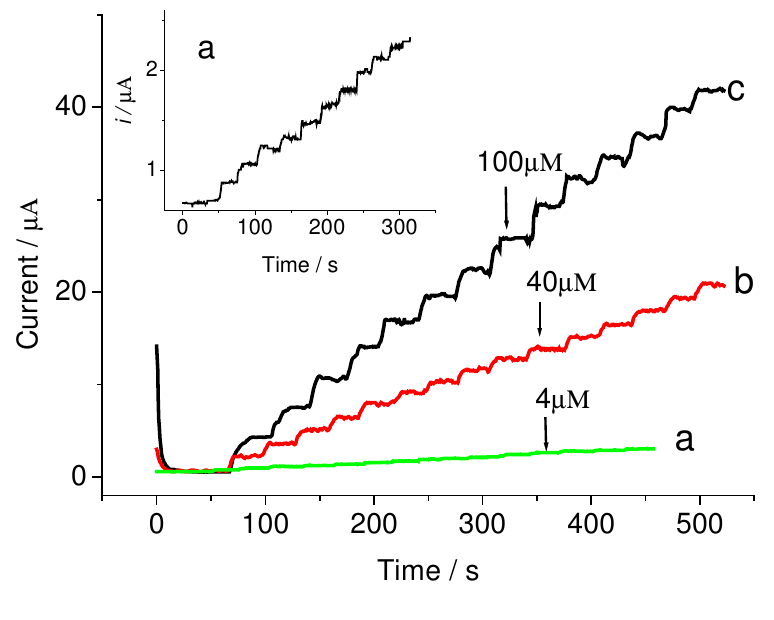
Figure 6 . Typical steady-state response of the sensor with an increasing H 2 O 2 concentration of 4 · 10 -6 M (a and inset A), 4 · 10 -5 M (b) and 1 · 10 -4 M (c) for each step at –0.4